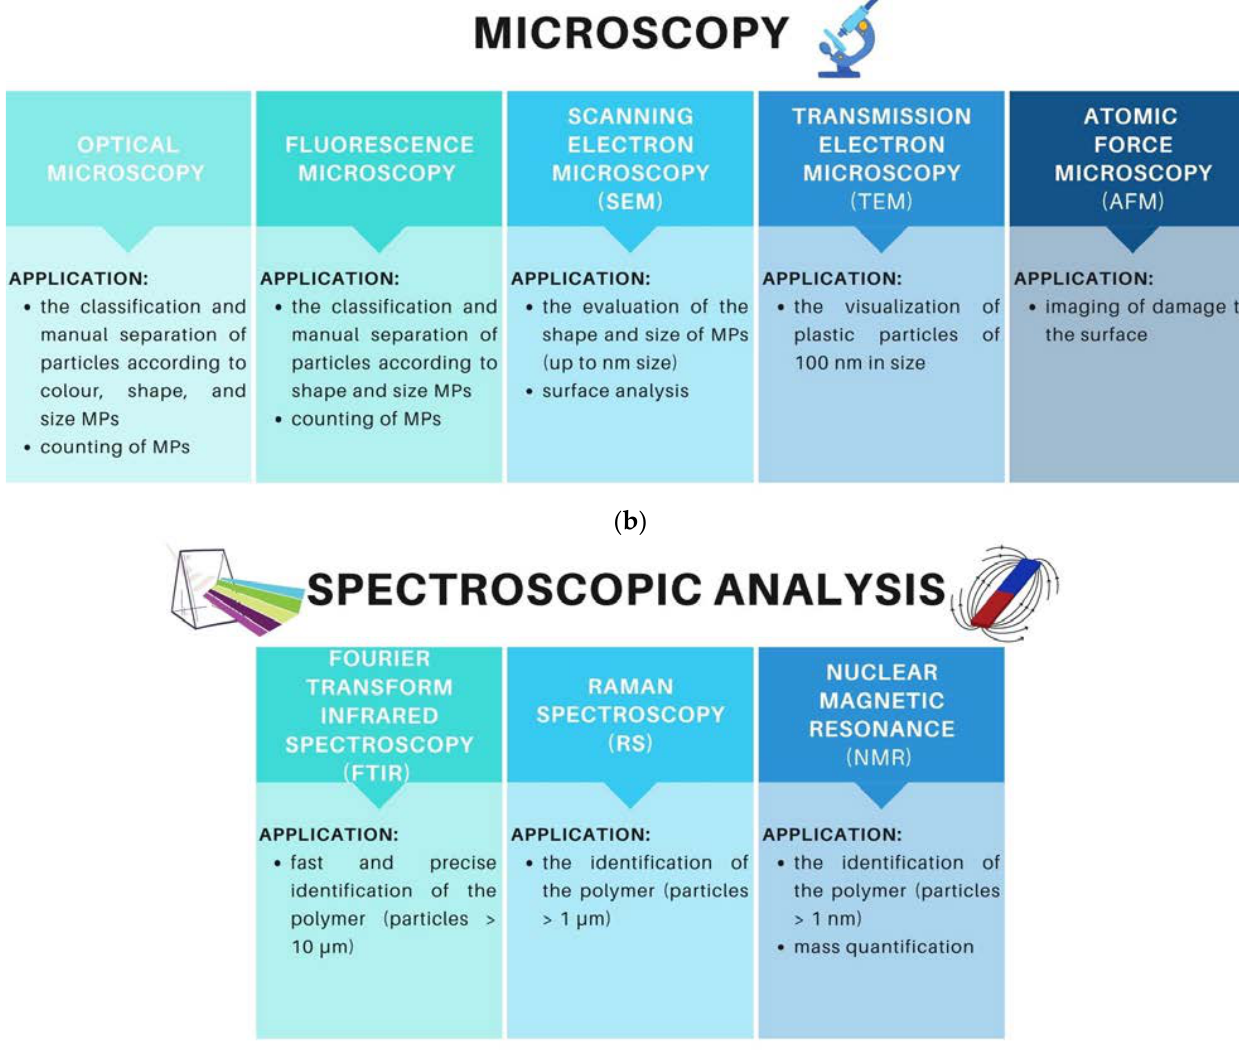
Figure 7. Identification methods of MPs ( a ) microscopy ( b ) spectroscopic analysis.